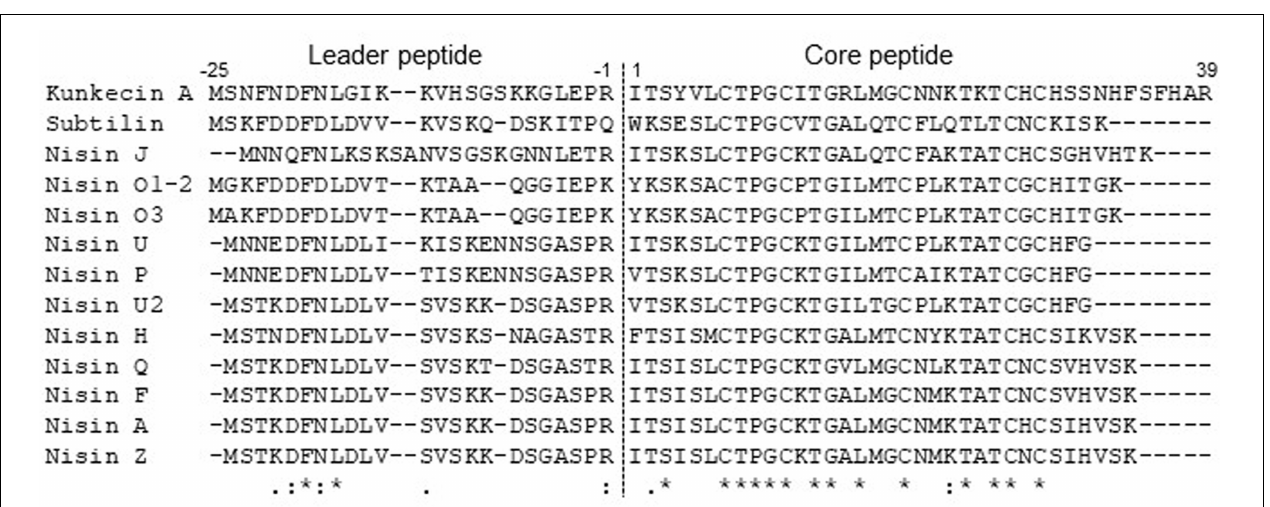
FIGURE 3 | Amino acid sequence alignment of precursor peptides of kunkecin A and nisin variants. Each precursor was aligned using the Clustal Omega program. The dotted line indicates the cleavage site of the leader peptides. Asterisks indicate fully conserved positions. Colons and periods indicate positions conserved by amino acid residues with strong and weak similarity,